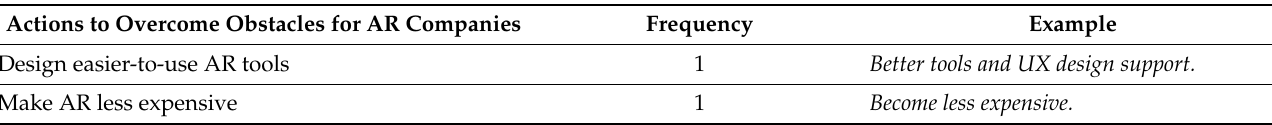
Table 19. Recommendations for AR